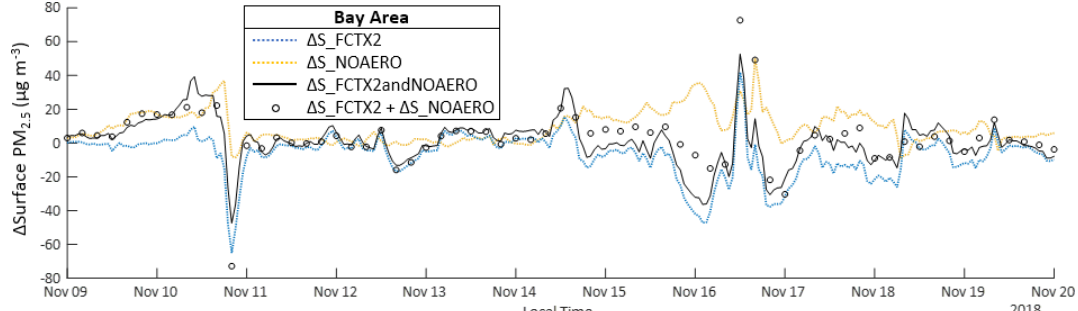
Figure 14. Comparison of surface PM 2 . 5 (µgm − 3 ) predicted by the joint perturbation experiment S_FCTX2andNOAERO with individual perturbation experiments (Table 1). (cid:49) S_* is the difference between each perturbation experiment (S_FCTX2 in dotted blue, S_NOAERO in dotted yellow, S_FCTX2andNOAERO in solid black) and the control experiment (S_CTRL). Black circles plot the sum of the effects from S_FCTX2 and S_NOAERO. Generally, the impact of the joint perturbation is similar to the sum of the two individual